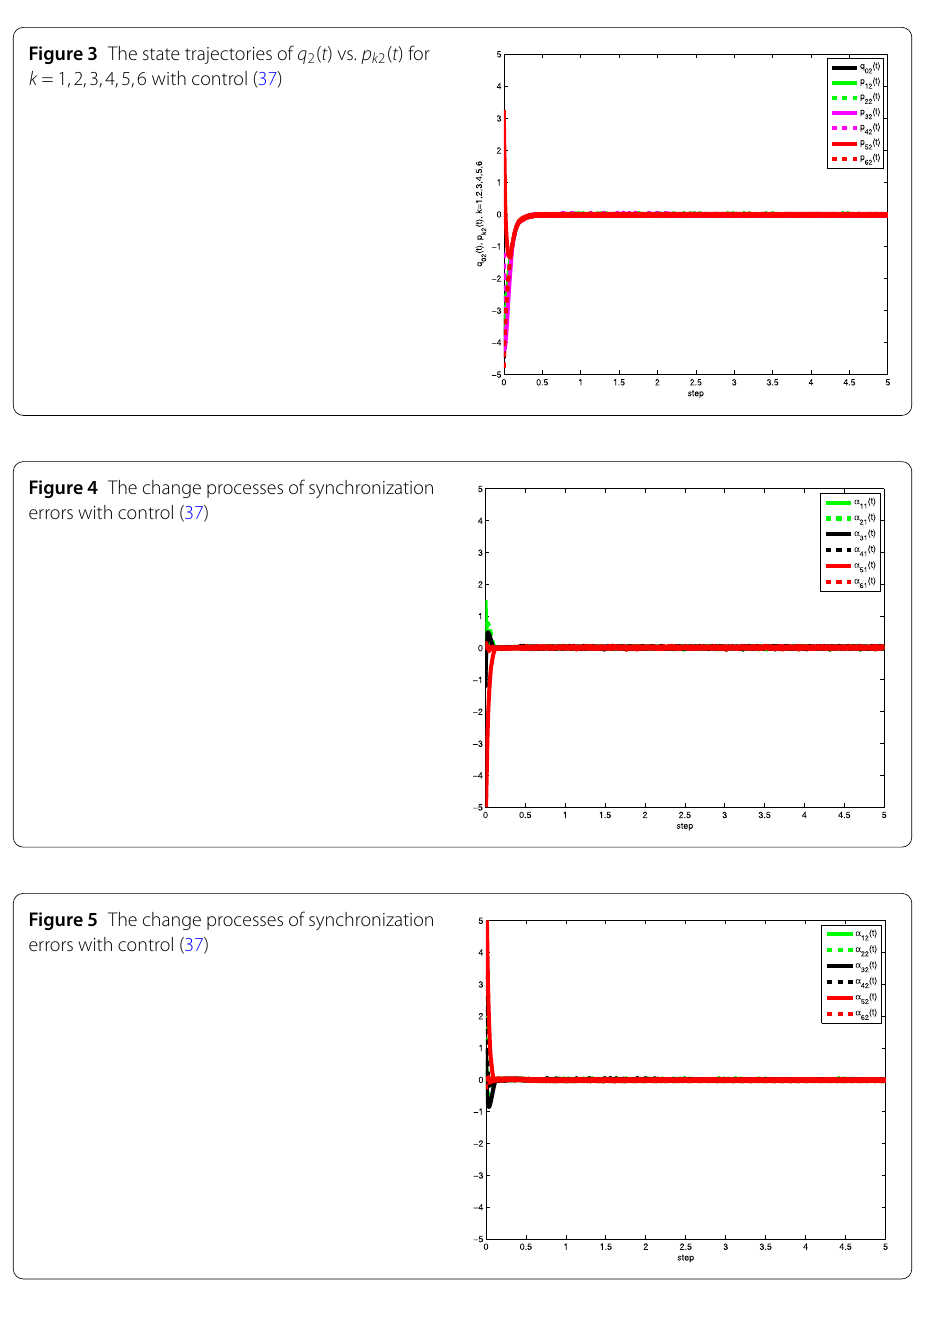
with the isolated